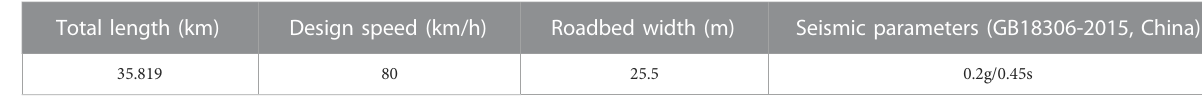
TABLE 1 Overview of the Zhen Qing Expressway.